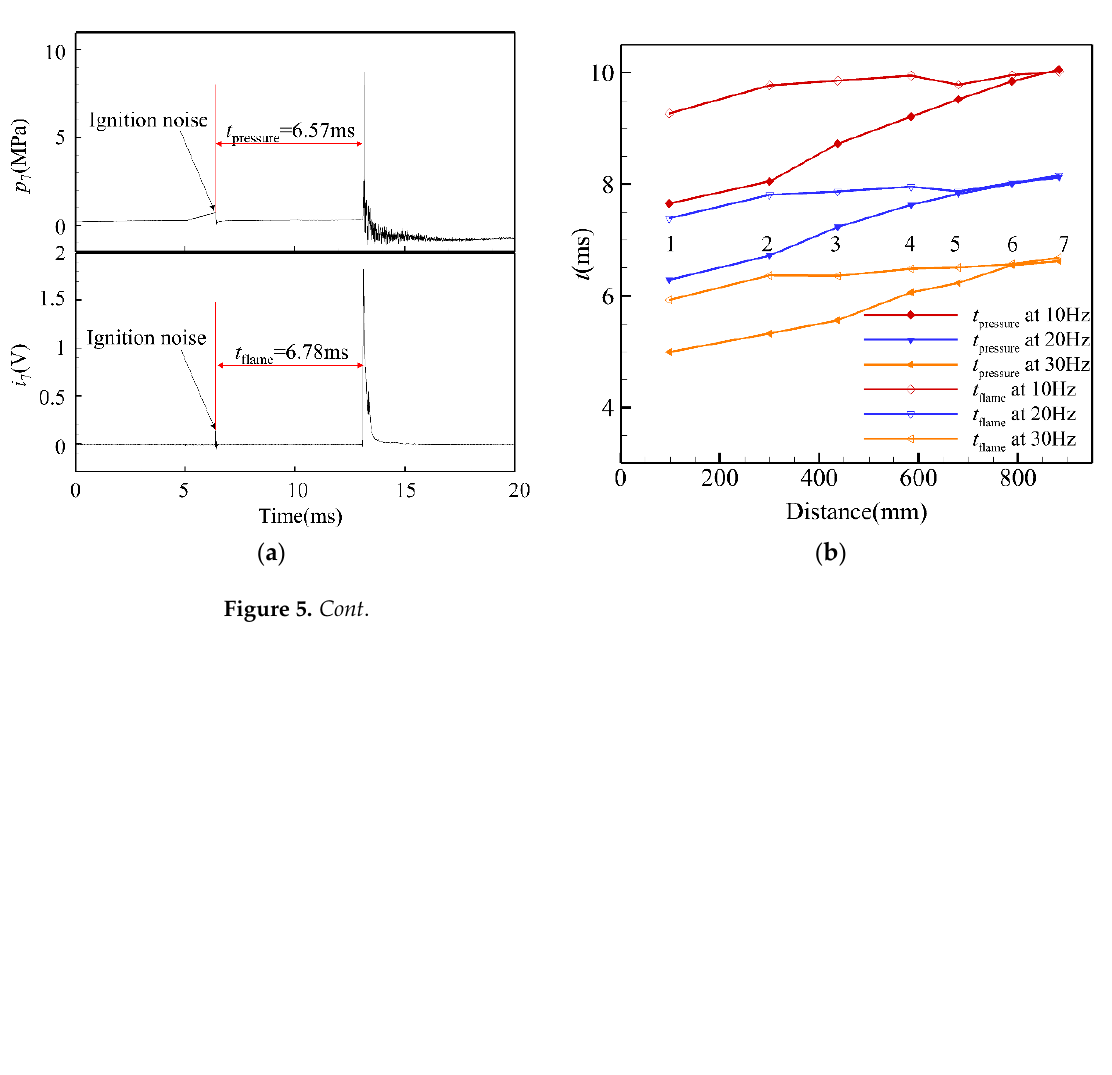
Figure 4. Flame propagation velocity in PDC measuring point 5~6 and measuring point 6~7 at different working conditions.